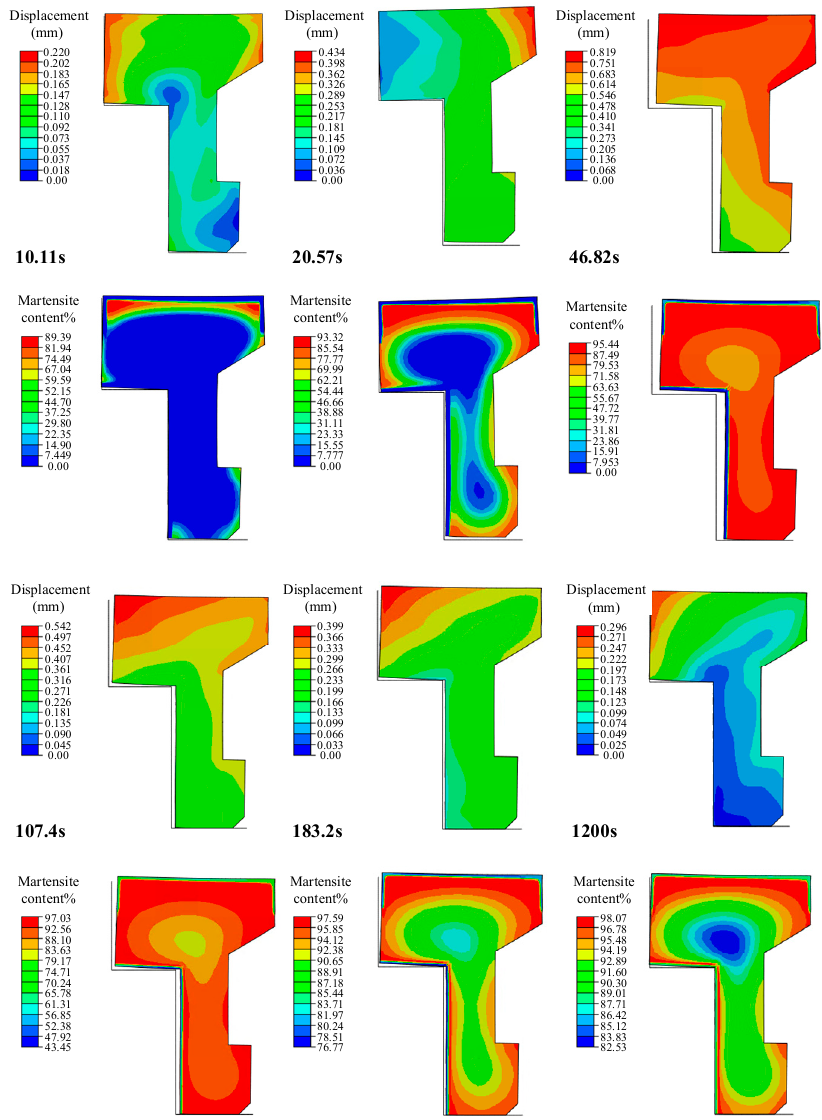
Figure 12. Gear deformation and martensitic transformation at critical time points. Four key positions were selected for deformation analysis: A and B represented radial displacement, while C and D represented axial displacement, as shown in Figure 13. The displacement changes at the key positions of the gear within 200 s of the quenching process are shown in Figure 14. The axial displacement and radial displacement both decreased in the initial stage of quenching, and the phase transformation began to occur at about 10 s, leading to increases in the displacements. The shrinkage deformation was greater than the expansion deformation at about 50 s, and the axial and radial displacements gradually decreased. Due to the limitation of the inner ring die, the radial displacement of B was less than that of A. Influenced by the warp of the tooth tip, the axial dis- placement of D located at the top of the tooth was larger than that of C.